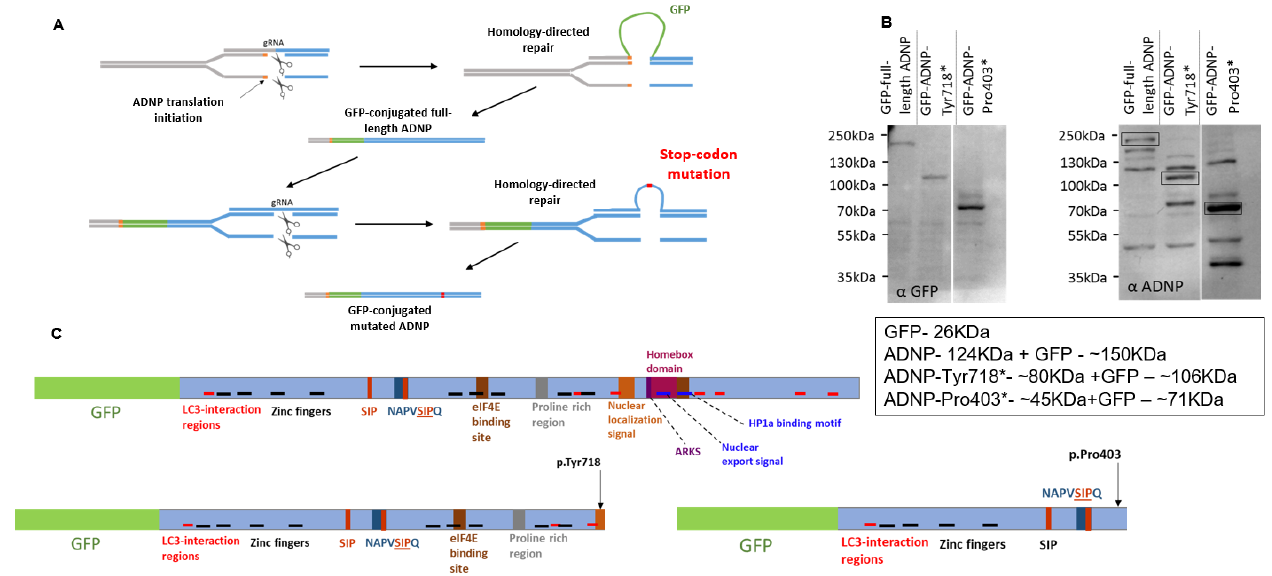
Figure 1. Cell model genome editing and validation. ( A ) Schematic representation of the CRISPR/Cas9 DNA-editing system used to establish neuroblastoma cell lines expressing full-length ADNP conjugated to GFP and truncated ADNP proteins. ( B ) Immunoblotting with anti-GFP ( left panel ) and anti-ADNP ( right panel ) antibodies was performed to confirm the expression of GFP- tagged proteins. The α -GFP panel depicts only GFP- conjugated proteins, while the α -ADNP panel depicts all ADNP immunoreactive forms. ( C ) Schematic representation of functional protein regions depicted along full-length ADNP and both mutants, adapted from our latest publication, which further identified SH3 domains, including NAPVSIP in the NAP sequence and an actin-binding site [2].